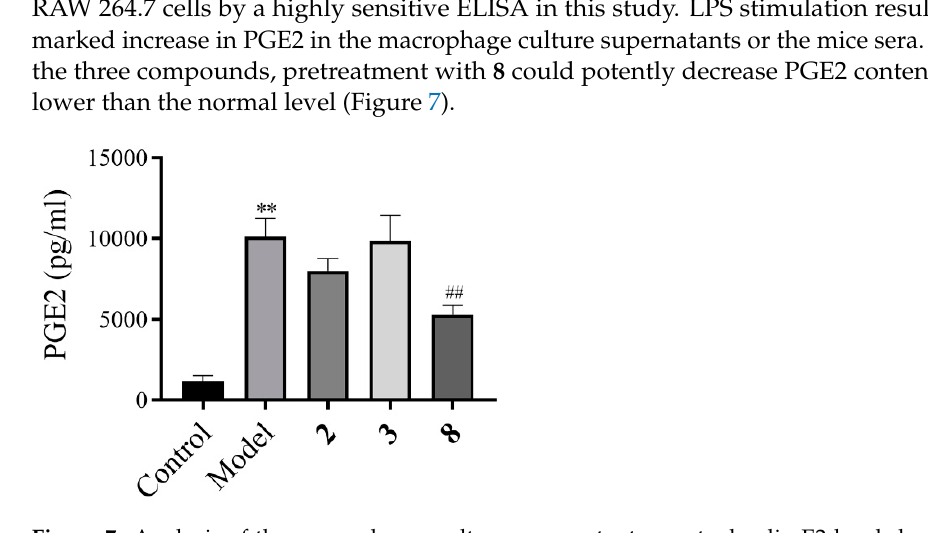
Figure 7. Analysis of the macrophages culture supernatants prostaglandin E2 levels by a highly sensitive ELISA, when treated with compounds 2 , 3 , and 8 . ** p < 0.01 vs. control group, ## p < 0.01 vs. model group.